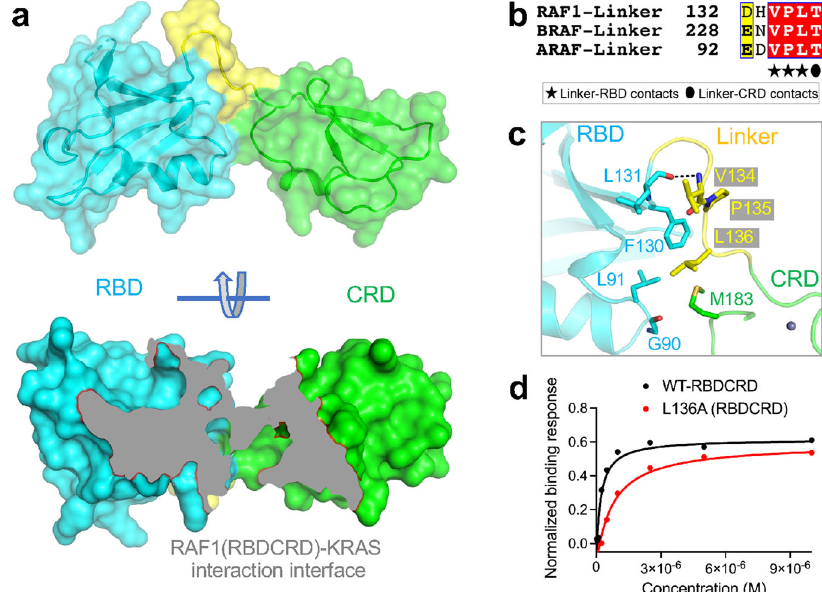
Fig. 3 Structural and mutational analyses of the role of linker residues present between RBD and CRD in the KRAS-RBDCRD structure. a The surface representation of RBDCRD showing how linker residues connect RBD and CRD, resulting in the formation of an extended structure. The lower panel shows the region of RBDCRD that interacts with KRAS (colored gray), suggesting RBD as well as CRD interact with KRAS. b Amino acid sequence alignment of residues present in the linker region of human RAF1, BRAF, and ARAF. Residues that are involved in the interaction with RBD and CRD are indicated below the alignment with stars and oval, respectively. c Enlarged view of the RBD and CRD interaction interface formed by residues present in the linker region. Residues that participate in interdomain interaction are shown in stick representation. A lone hydrogen bond is shown as a black dashed line. d Steady- state binding isotherms derived from the SPR data for the WT-RBDCRD and L136A mutant present in the linker region binding to